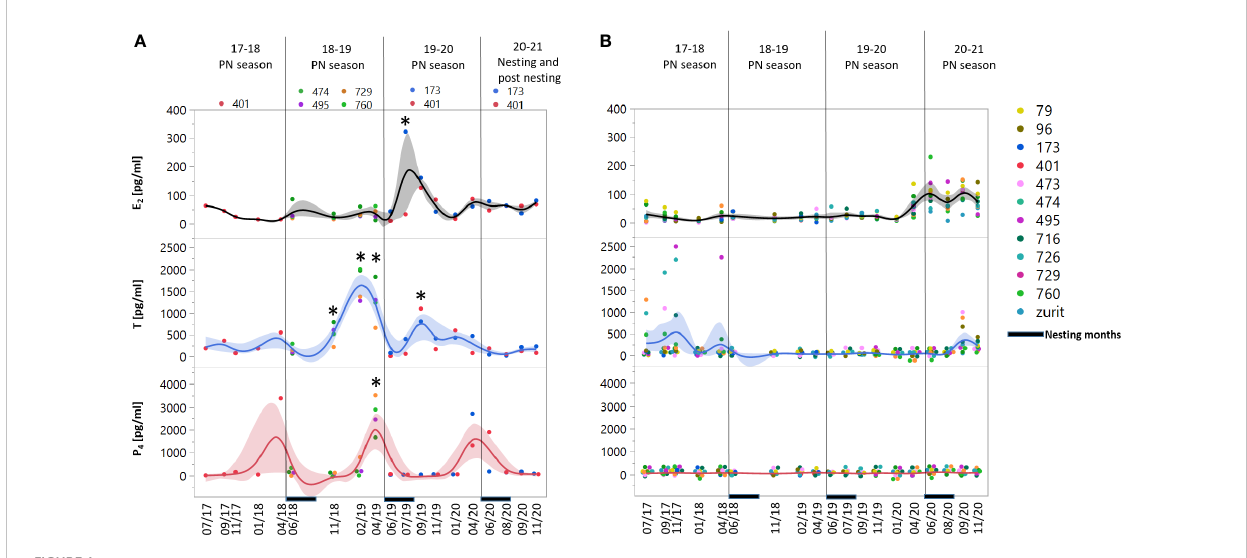
FIGURE 1 Concentration measurements of sex steroids: estradiol (E2), testosterone (T) and progesterone (P4) in female green turtles, (A) Future nesters (FN) and (B) Non-nesters (NN). Measurements are represented for 19 sampling dates in the period of 2017-2020 divided to 3 pre-nesting (PN) seasons – 2017-18, 2018-19 and 2019-20 and the last nesting/posting season, the nesting period marked at the X axis. At the left panels, asterisk represents signi fi cant difference between the two groups p= 0.05. Shaded areas represent the con fi dence of fi